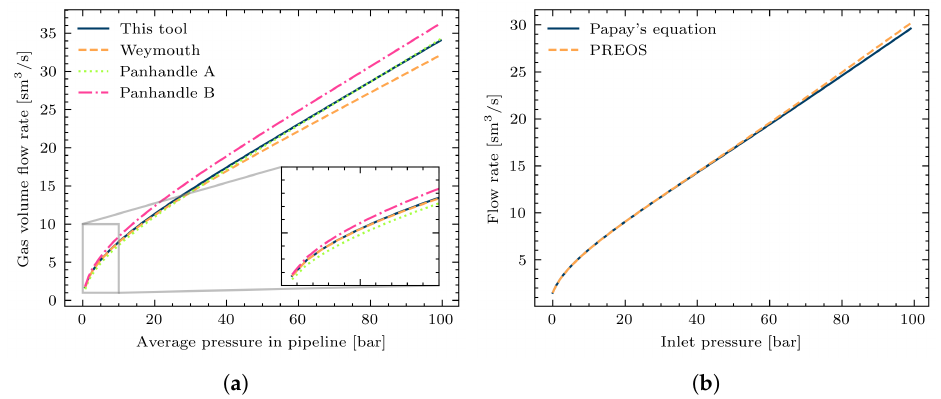
Figure 2. ( a ) Comparison between different pipeline flow rate calculation methods. ( b ) Comparison of flow rate calculation with constant gas properties and those calculated using PREOS.